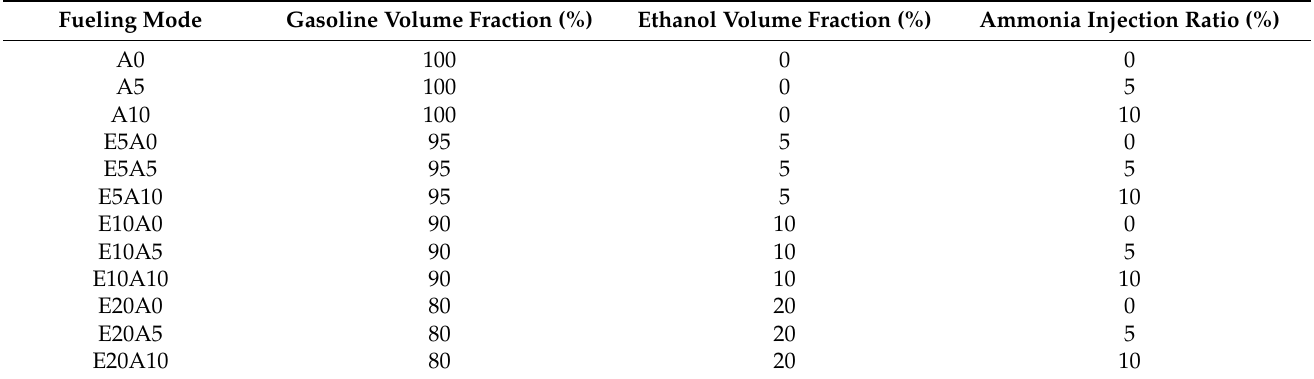
Table 2. Various fueling modes definitions in this